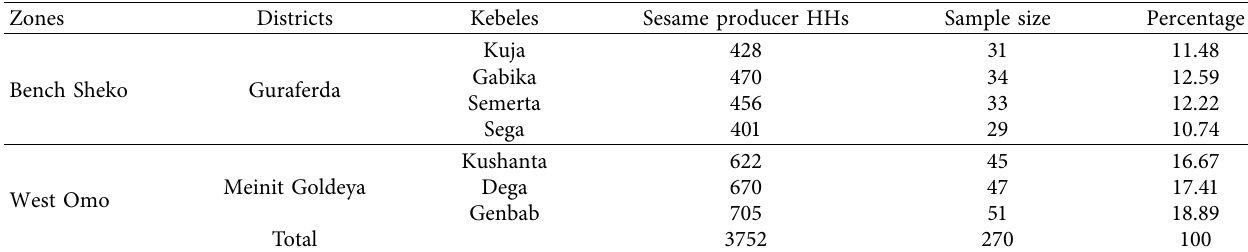
Figure 1: The study area’s geographical Table 1: A brief description of the sample frame and sample size.